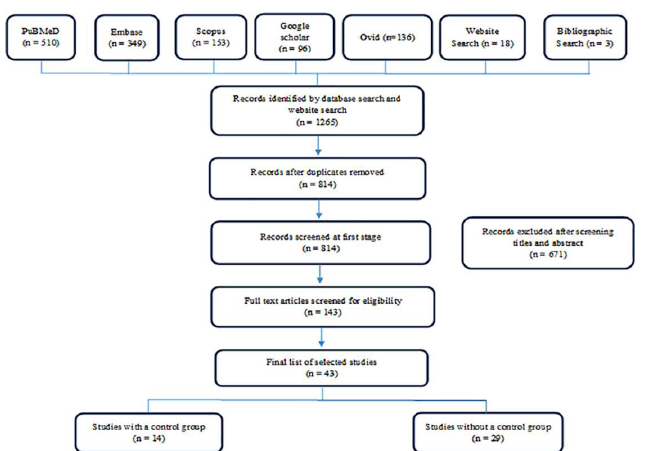
Fig 1. Flowchart showing selection of